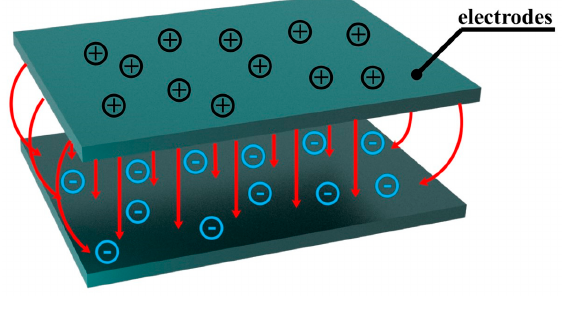
Figure 1. Parallel plate capacitor.